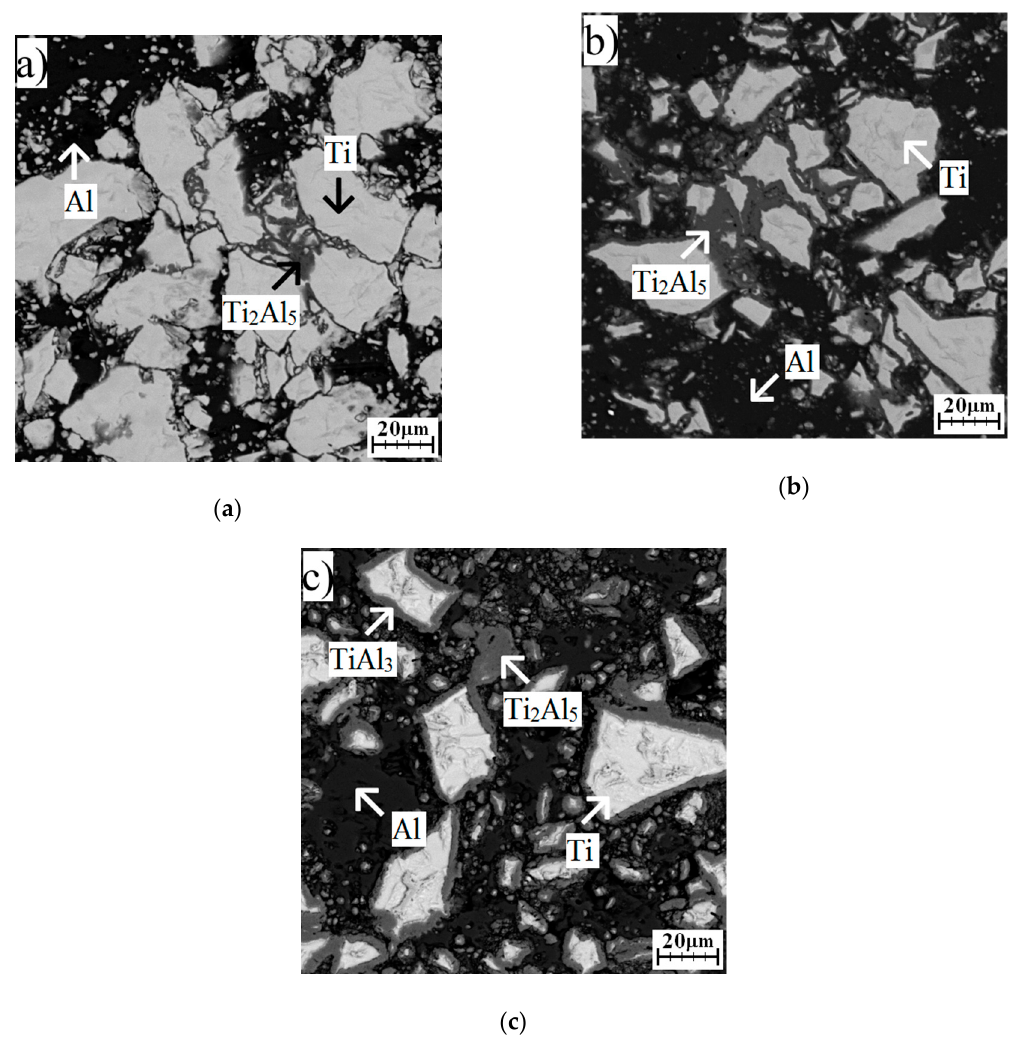
Figure 6. The microstructure of TiAl63 alloys annealed at 500 °C for ( a ) 8 h, ( b ) 24 h, and ( c ) 48 h.